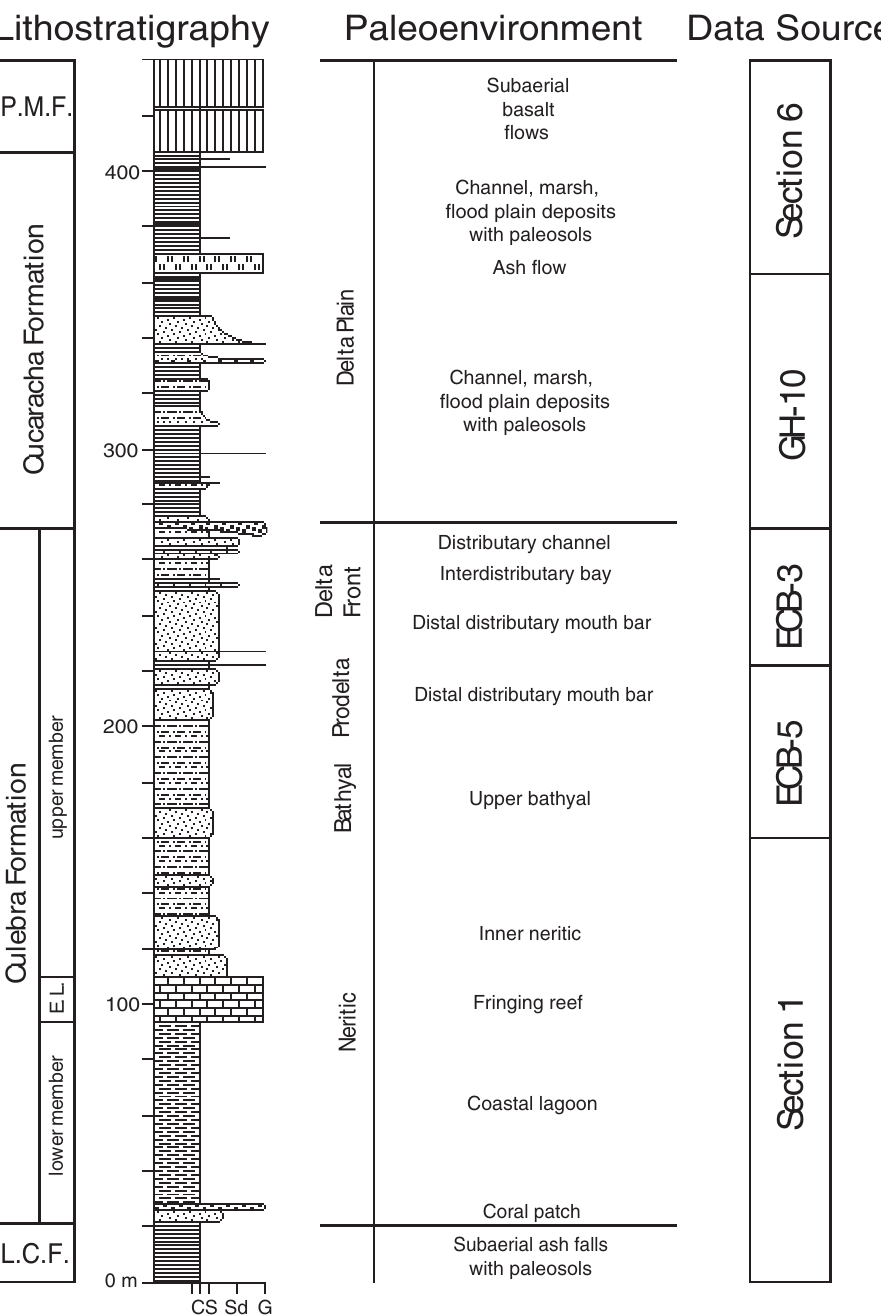
Figure 9. Composite stratigraphic section of the formations along the Gaillard Cut, Panama Canal Basin, showing lithostratigraphy and palaeoenvironmental interpretations, based on stratigraphic relationships illustrated in Figure 6. ‘‘Data Source’’ indicates the stratigraphic sections used to compile the composite section. L.C.F.=Las Cascadas Formation. E.L.=Emperador Limestone. P.M.F.=Pedro Miguel Formation. Abbreviations at the base of the section represent grain size (C=Clay; S=Silt; Sd=Sand;